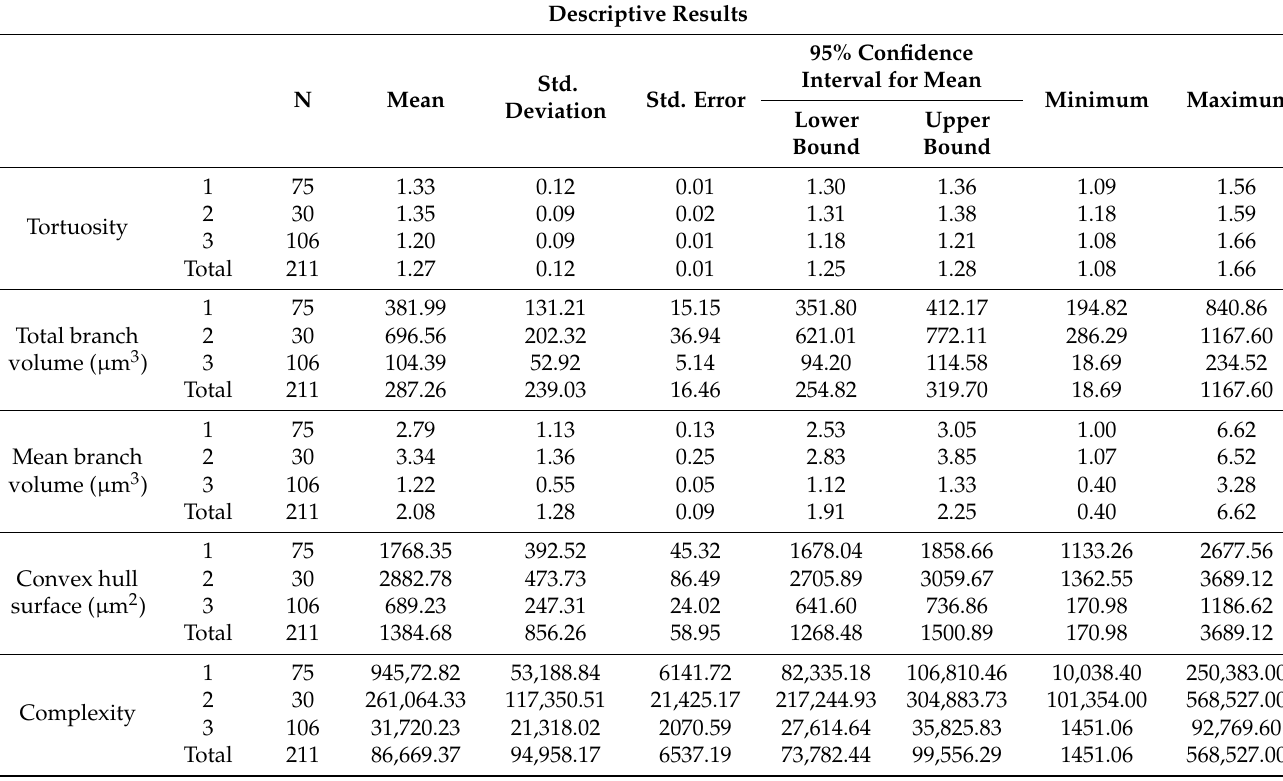
Table 2. Descriptive statistical results for morphometric variables that contributed most to the formation of clusters. The data for the clusters are shown as 1, 2, and 3 on each line. Clusters 1 and 2 correspond to the microglia of the infected animals, and cluster 3 represents microglia of control animals. Note that the lowest mean values for each variable were in cluster 3 (control animals) and the highest values in cluster 2 (one group of infected animals).